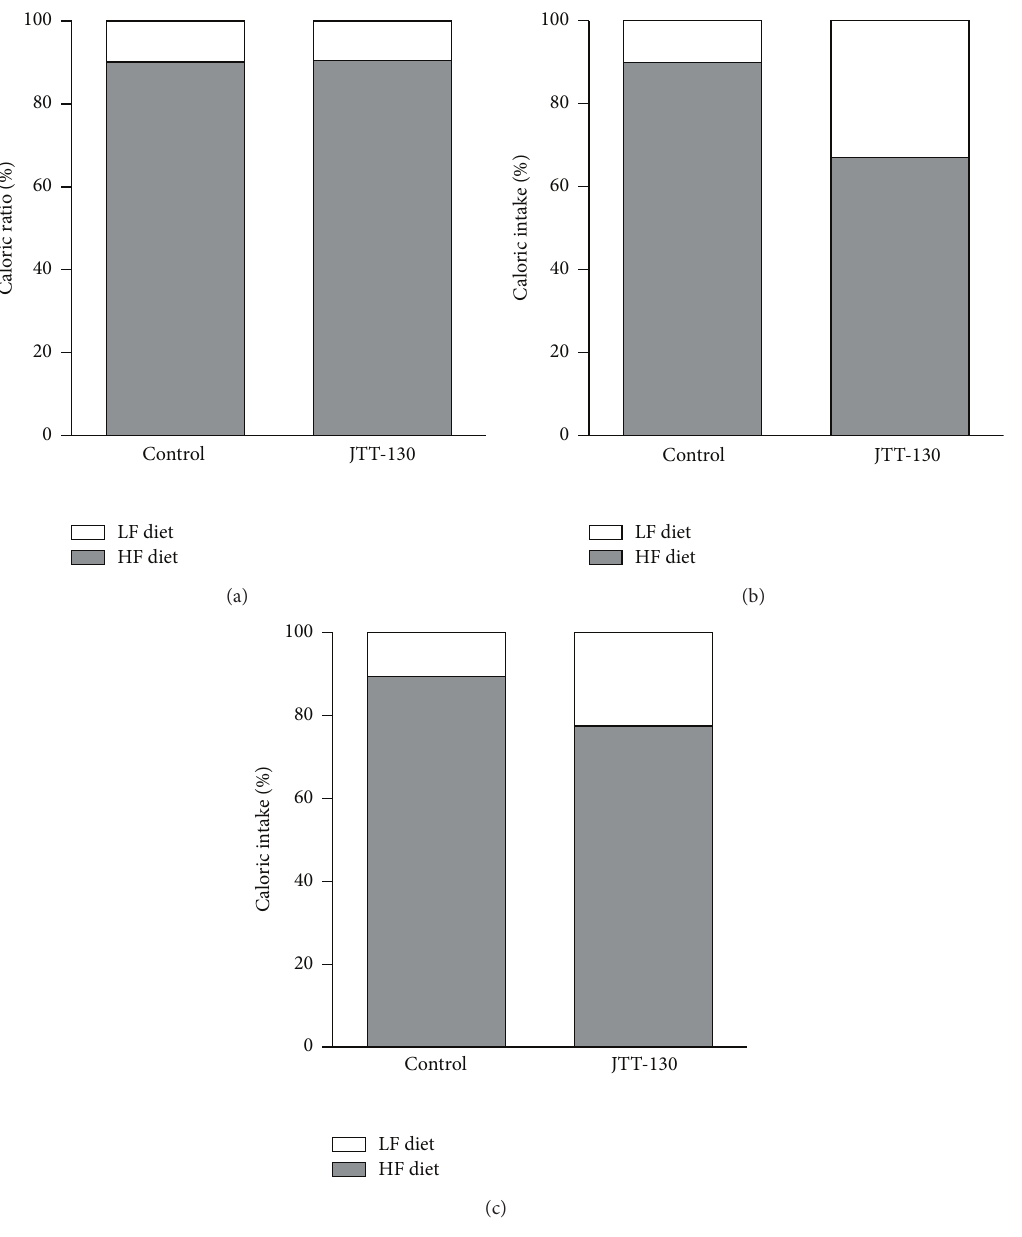
Figure 3: Effects of JTT-130 on caloric intake ratio from LF and HF diets. Caloric intake ratios were calculated from average daily intake from LF and HF fat dietsduring baseline (a), the treatment period (b), and recovery period (c). Data are presented as means ± S.E. from ten